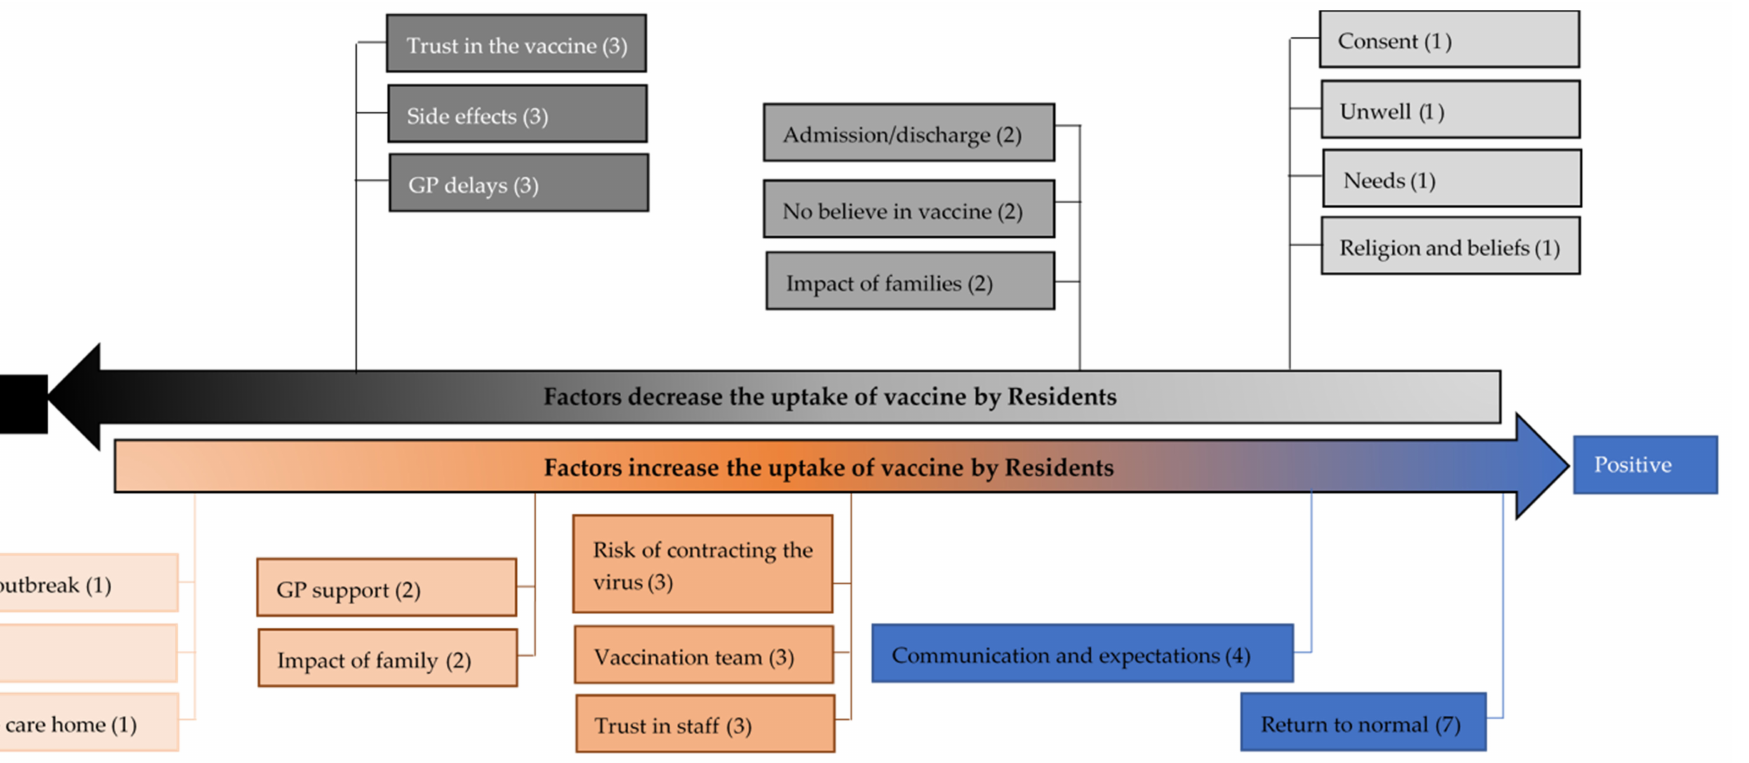
Figure 2. Positive and negative codes that affect the uptake of vaccine by